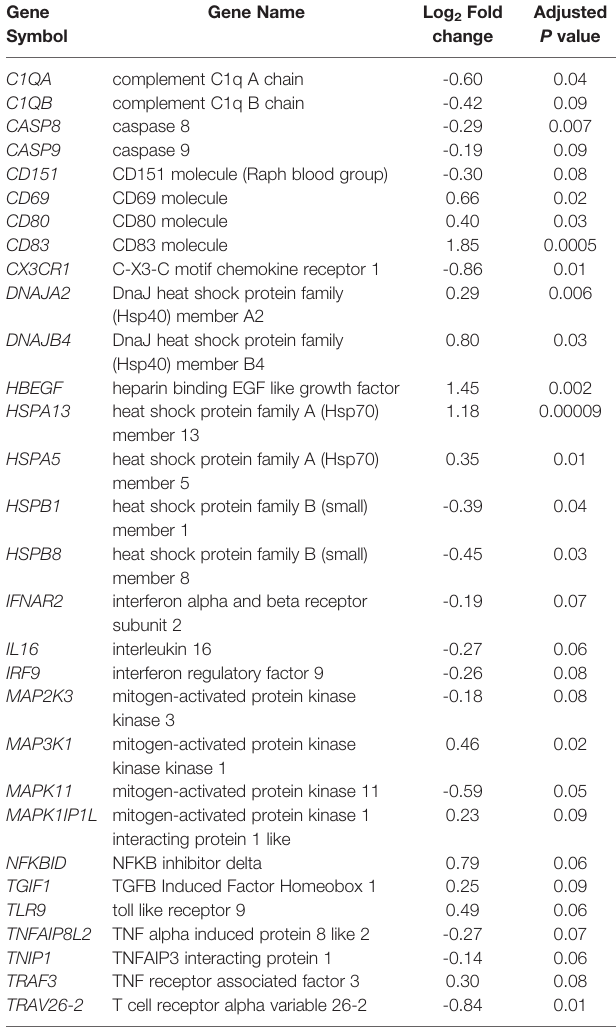
TABLE 1 | Immune response-relatedDE genes at 2 wpi (infected vs control analysis). Gene Symbol